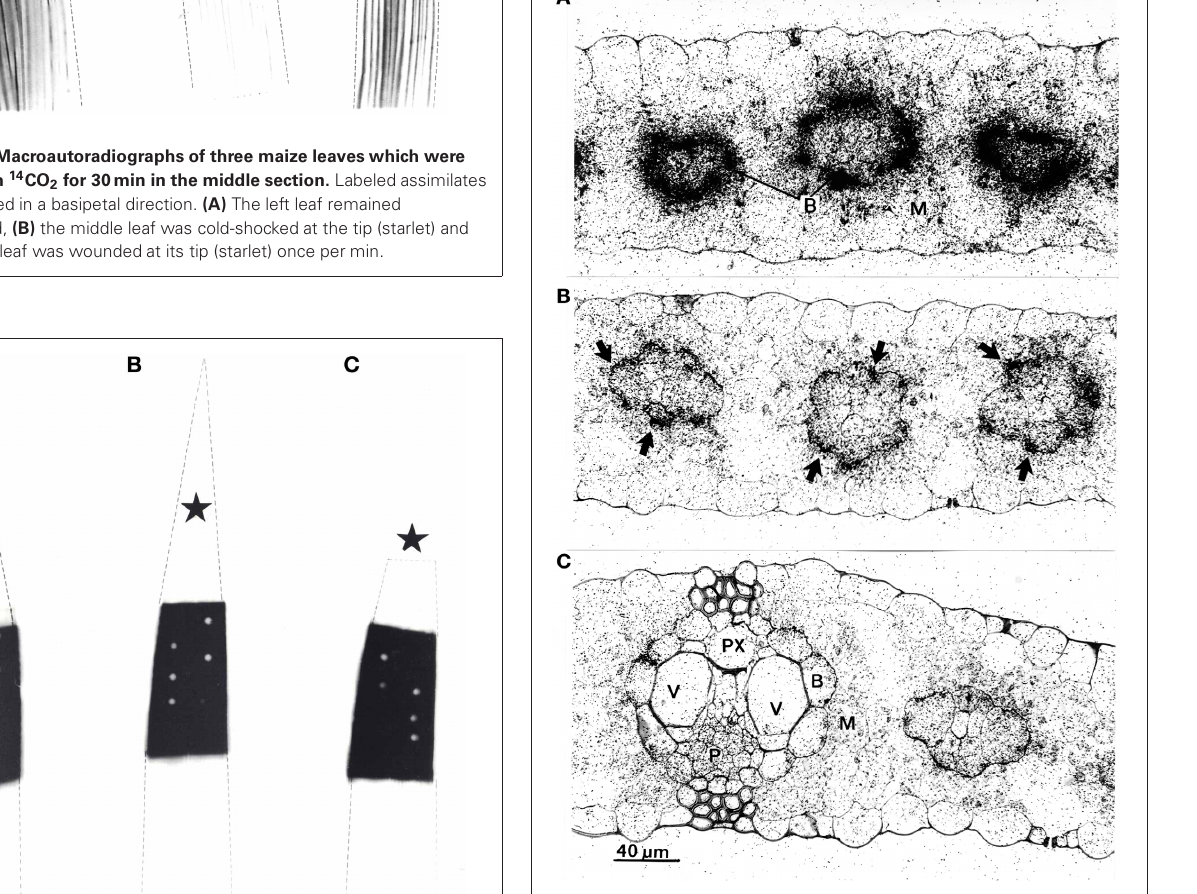
FIGURE 4 | Macroautoradiographs of three maize leaves which were labeled with 14 CO 2 for 15min in the middle section. (A) Unstimulated control leaf, (B) cold-shocked leaf at the tip (starlet) and (C) wounded leaf at the tip (starlet). The leaves were stimulated once per min. At the white circles within the labeled leaf blades samples were taken for microautoradiography.